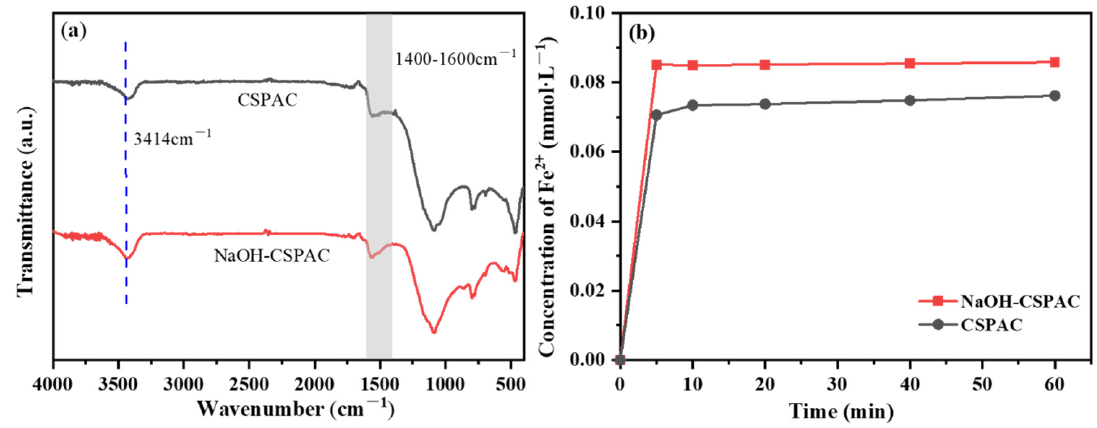
Figure 13. FT-IR spectra of NaOH-CSPAC and CSPAC ( a ) and concentrations of Fe 2+ generated by NaOH-CSPAC and CSPAC in the Fe 3+ /CSPAC system ( b ).